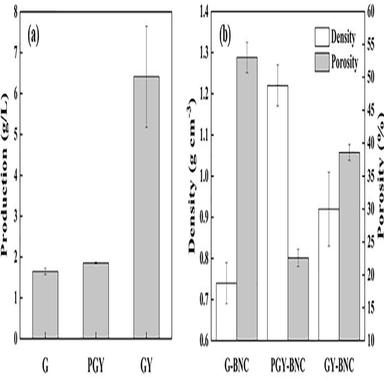
Production (a), density, and porosity (b) of BNC from G (glucose), PGY (pure glycerol), and GY (crude glycerol).